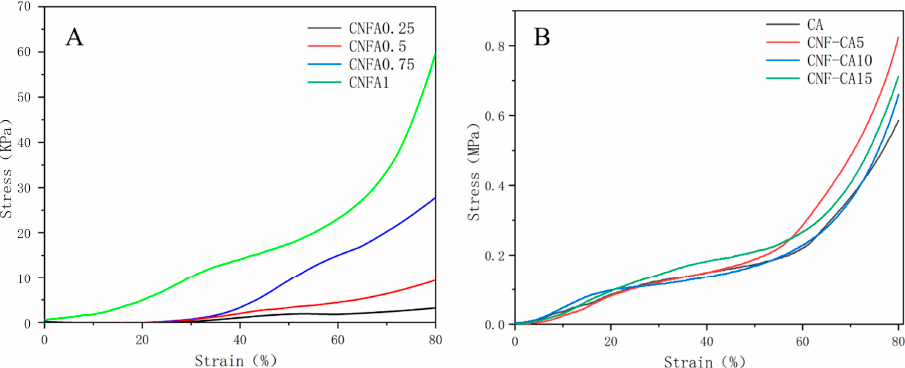
Figure 8. Compressive stress and strain curves of CNF aerogel ( A ) and composite cellulose aerogel ( B